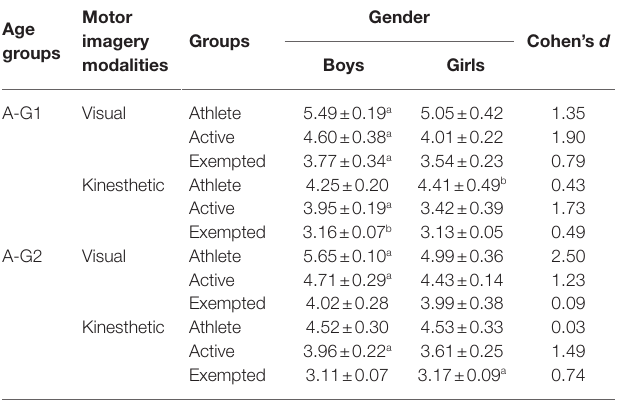
TABLE 6 | Gender effect on motor imagery vividness. Motor Age groups